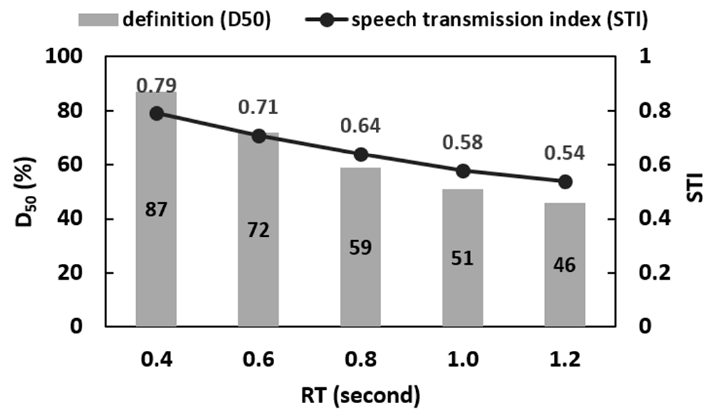
Figure 5. Speech intelligibility in the classroom by reverberation time.